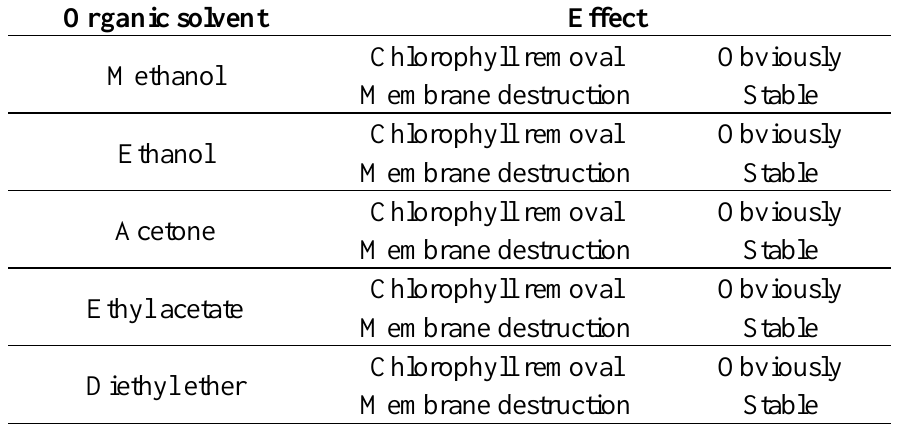
Figure 5. Determination of chlorophyll content in the PVDF membrane by washing with organic solvent. The chlorophyll content was presented as mean ± SD. Using SPSS 11.5, the data was statistically analyzed by ANOVA (least significant difference). The